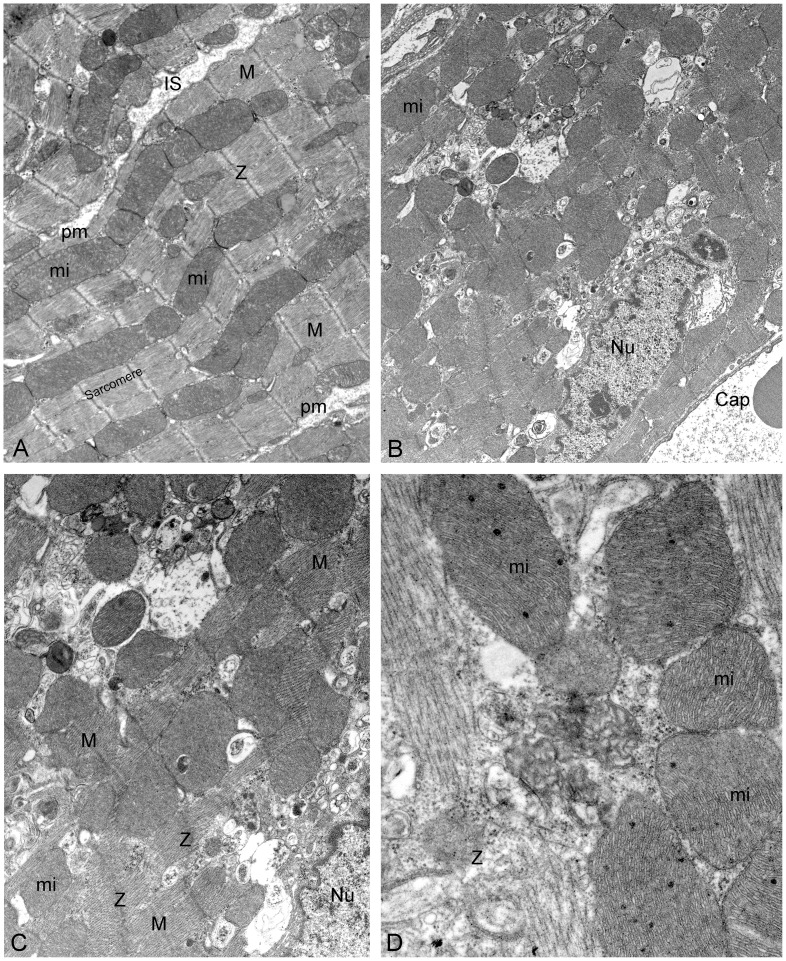
Electron microscopic study of the mice myocardium 24 hours after septic injury and sham-operation.
A. The ultrastructural examination revealed that the myocardium from control mice did not differ from that reported in the literature presenting continuous and regularly spaced myofibrils that alternate with serially arranged, elongated mitochondria (mi). Sarcomeres are clearly delimited by two neighboring well-defined Z-bands. Interfibrillar mitochondria are closely related to the sarcomere. Magnification bar represents 2 µm. B. The ultrastructure of the myocardium of mice with severe sepsis 24 hours after CLP showed ill-defined sarcomeres with abundant accumulation of autophagolysosomes within cardiomyocytes (arrows). Magnification bar represents 2 µm. C. Higher magnification showing autophagolysosomes (arrows), foci of ill-defined and disorganized/disrupted sarcomeres and blurring/breakage of Z-bands (Z). Magnification bar represents 1 µm. D. Increased number of electron-opaque calcium granules within mitochondria (arrow heads), breakage of Z band (Z) and autophagolysosome (arrow). Magnification bar represents 500 nm. M, M line; Nu, nucleus; pm, plasma membrane; IS, interstitial space; Cap, capillary.